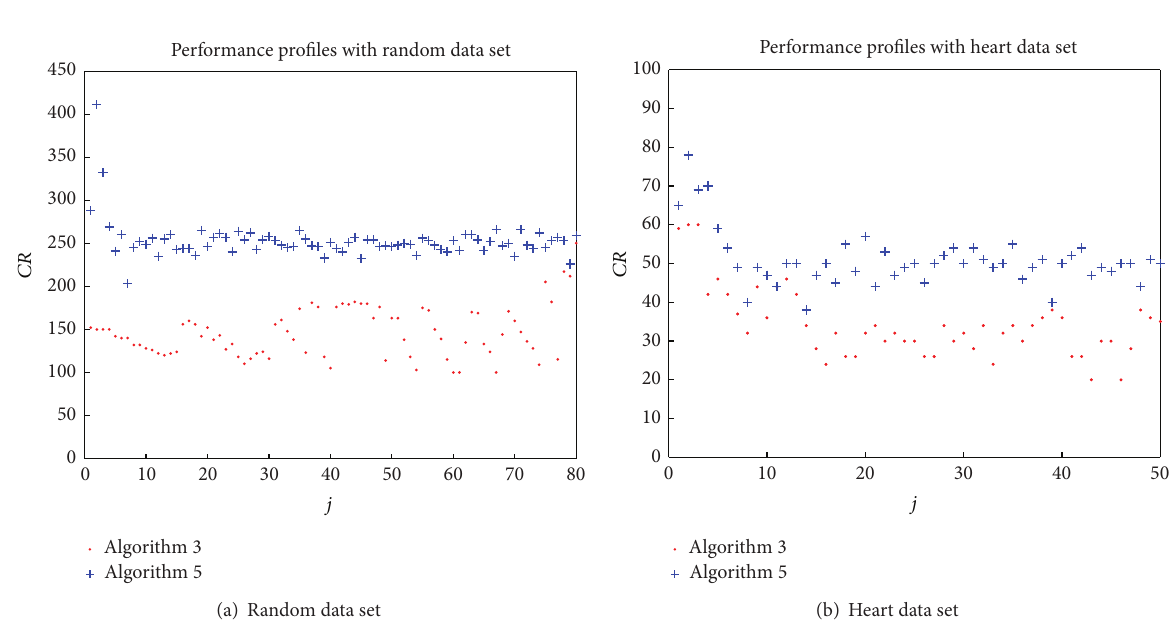
Figure 1: Function value curve with iterations.